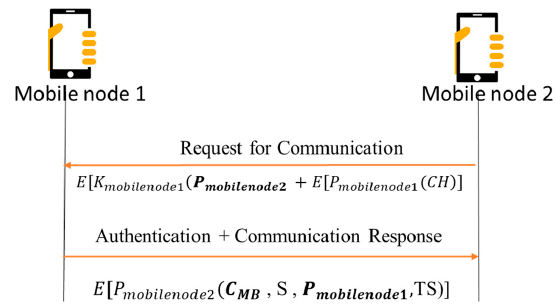
Figure 4. Showing the decreased communication cost between two